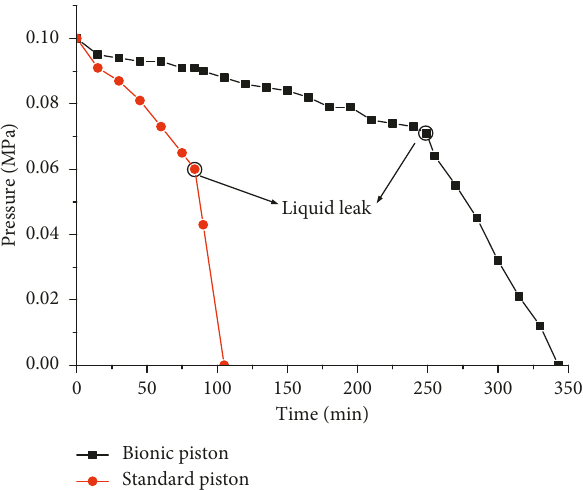
Figure 6: The pressure changes during the operations of the pistons.